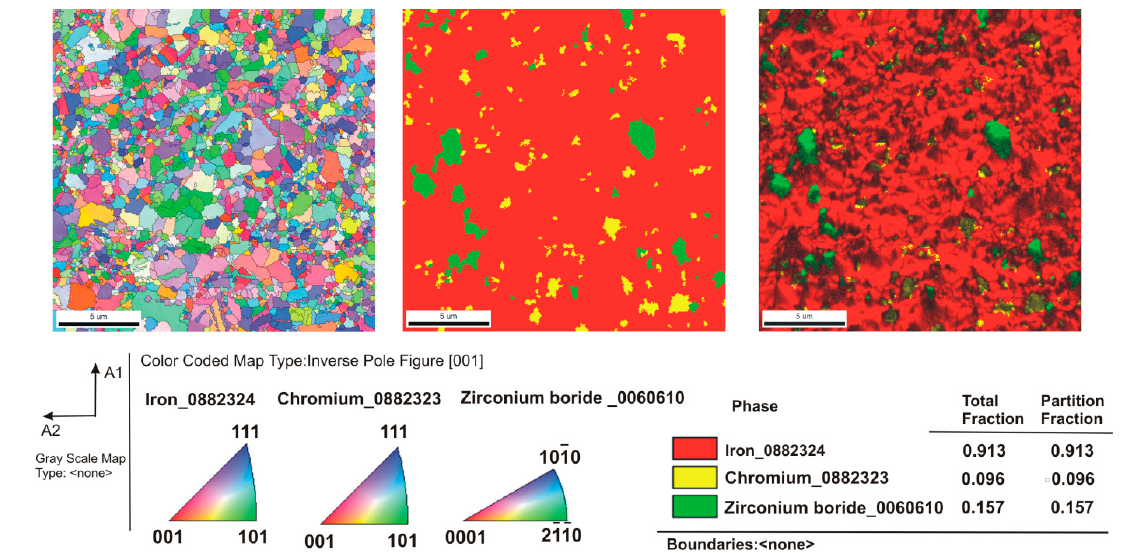
Figure 5. The SEM image of steel+10% TiB 2 composite with WDS analysis.